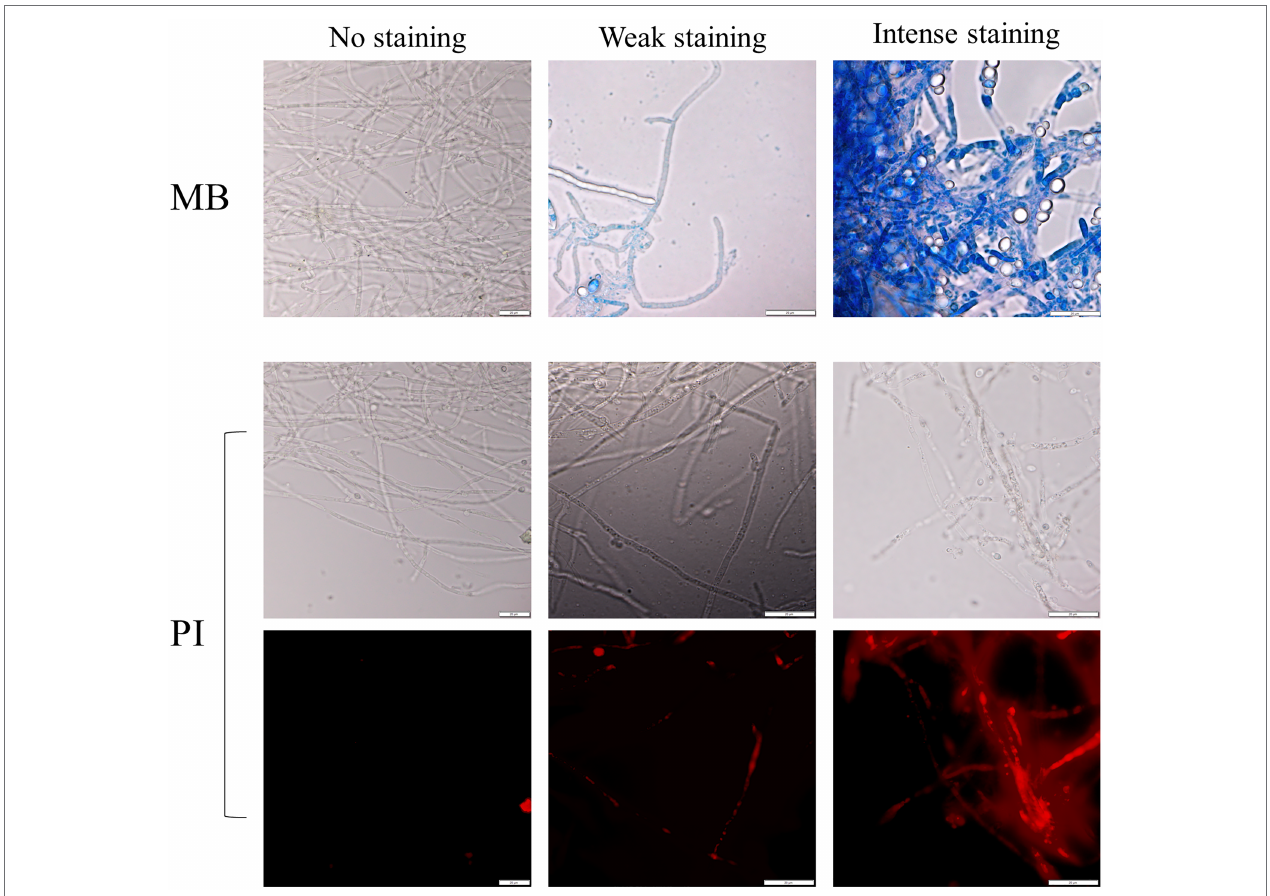
FIGURE 3 | Examples of the yeast/filamentous fungal strains cultures stained with MB (upper panel) and PI [corresponding to the observed bright field (middle panel) and fluorescence (lower panel) of the same picture, respectively]. The absence of staining is compared with two degrees of staining, weak, and intense. Scale bar: 20 μ